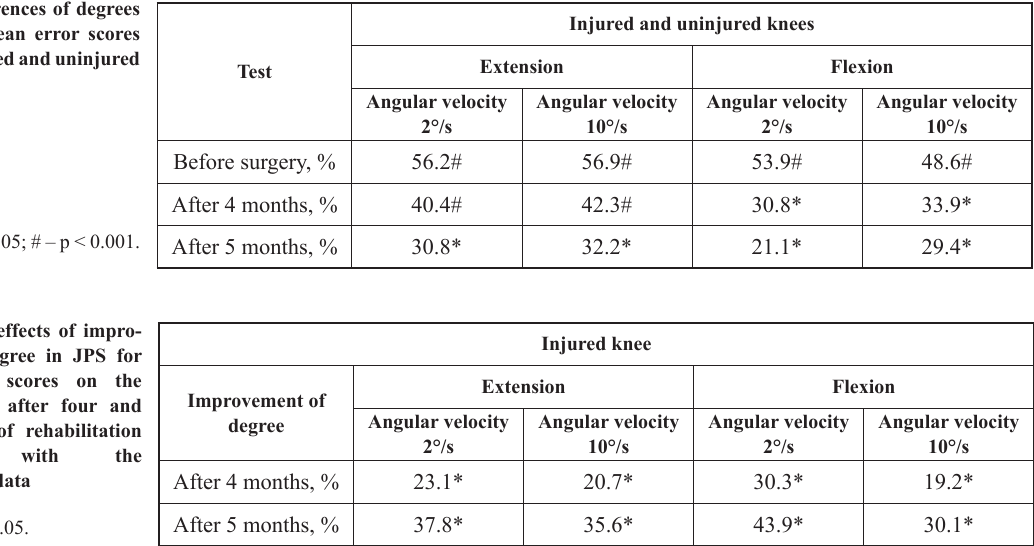
Table 1. Differences of degrees in JPS for mean error scores between injured and uninjured knees